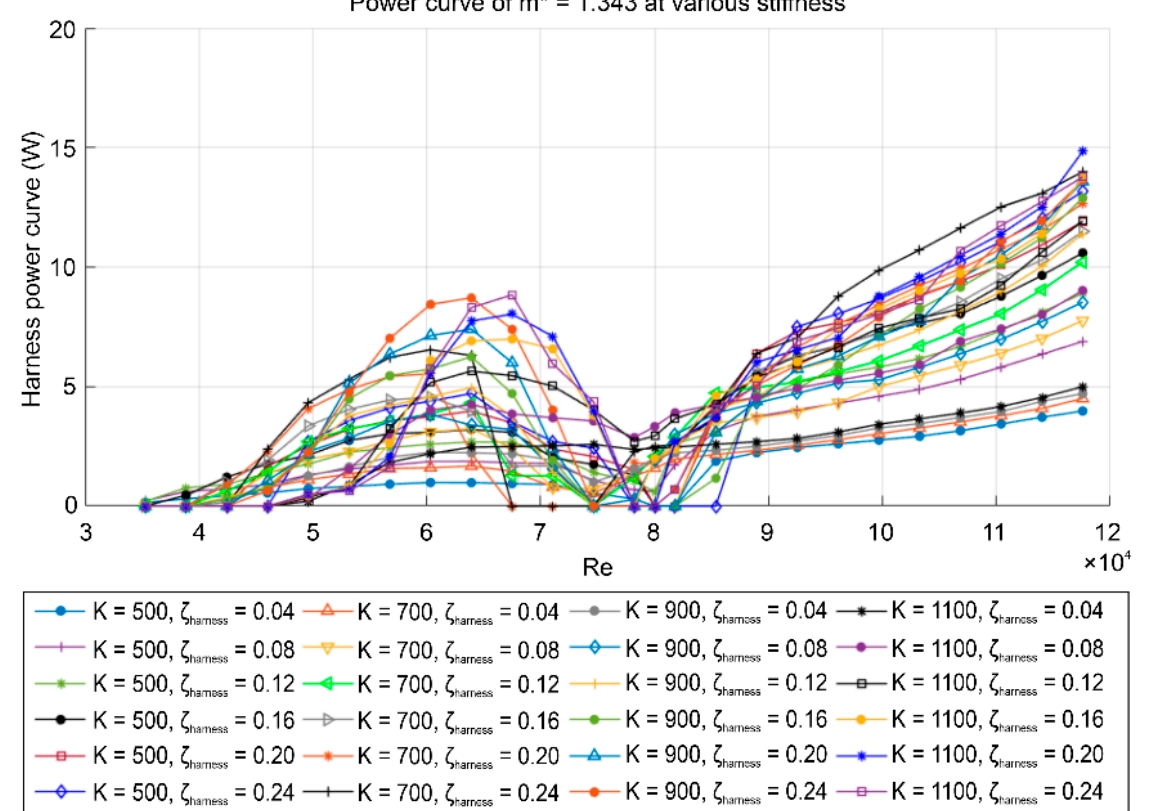
Appl. Sci. 2021 , 11 , x FOR PEER REVIEW 15 of 17